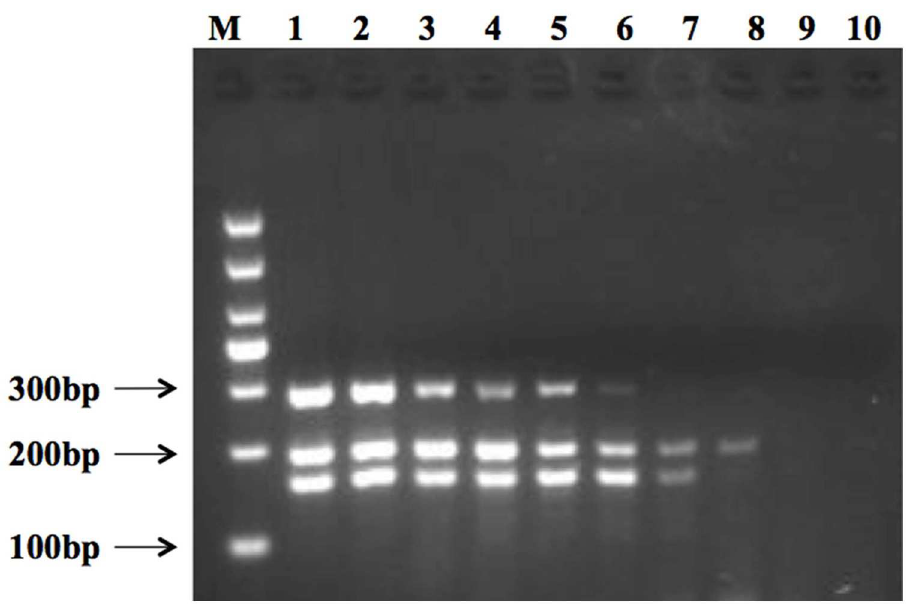
Fig 4. The sensitivity of the multiplex PCR assayusing 10-fold serial dilutions of L . monocytogenes , E . coli O157:H7, and S . aureus . Lanes1 to 8 show ampliconresults for L . monocytogenes (from 2.3 × 10 8 cfu/ml to 2.3 × 10 cfu/ml), E . coli O157:H7 (from 1.8 × 10 8 cfu/ml to 1.8 × 10 cfu/ml), and S . aureus (from 3.4 × 10 8 cfu/ml to 3.4 × 10 cfu/ml). Lane 9 and Lane 10 show the results of the